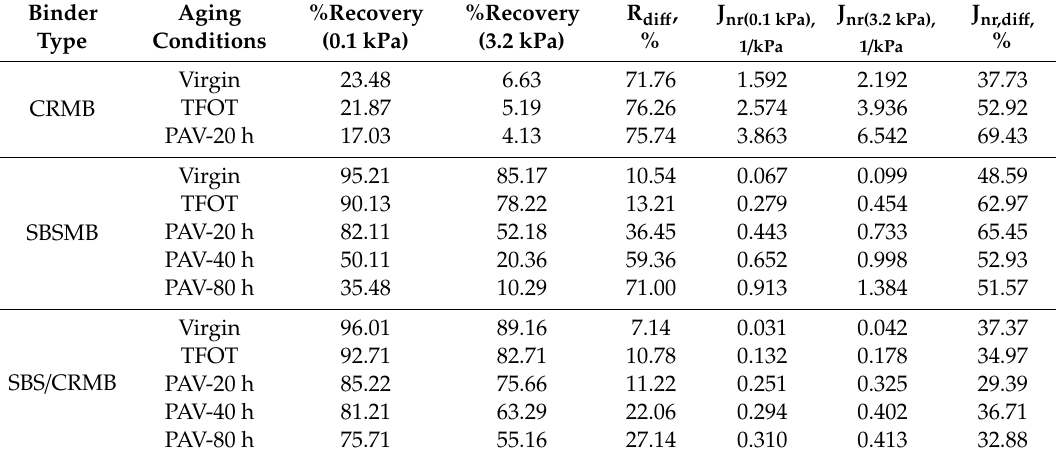
Table 2. Multiple Stress Creep Recovery test results for three kinds of asphalt binder in di ff erent aging conditions.